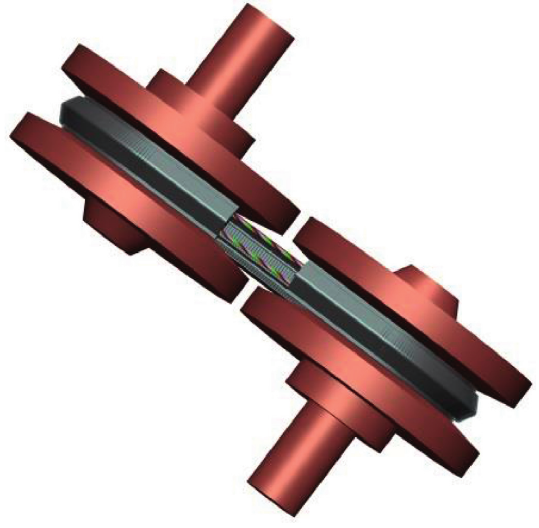
Figure 4: WR-CVT assembly.